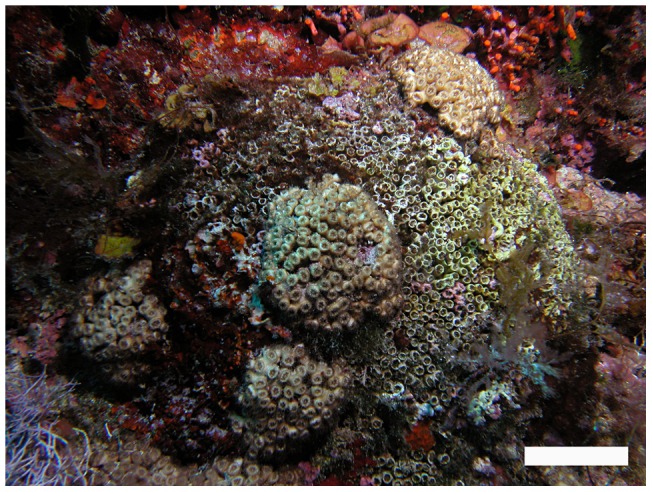
“Colony-on-colony” recruitment in a necrosis-affected C. caespitosa colony.Scale bar: 5 cm.